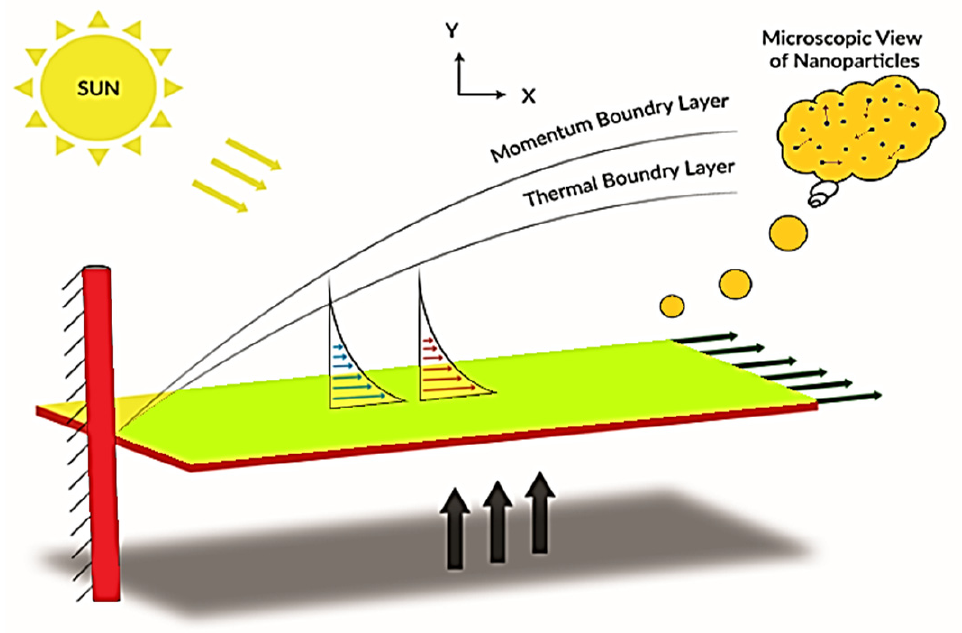
Figure 3. Schematic illustration of the flow